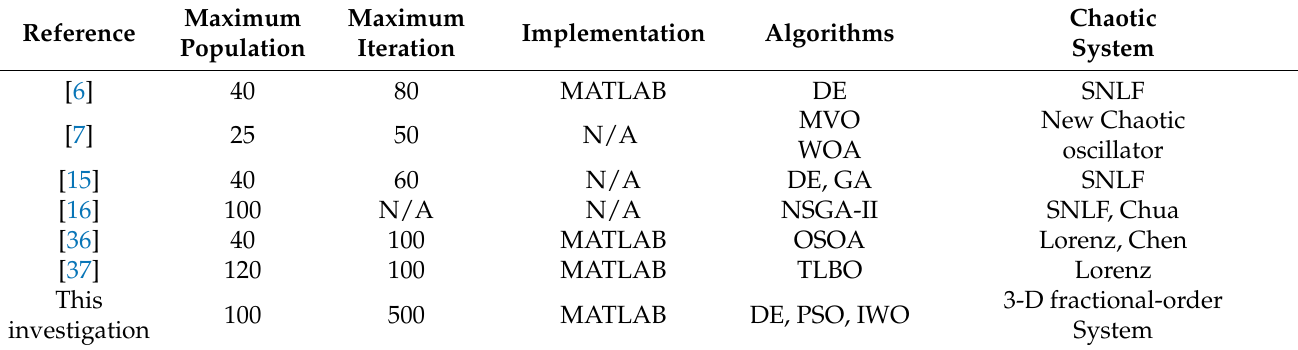
Table 4. Comparison of the chaotic behavior optimization with some other similar